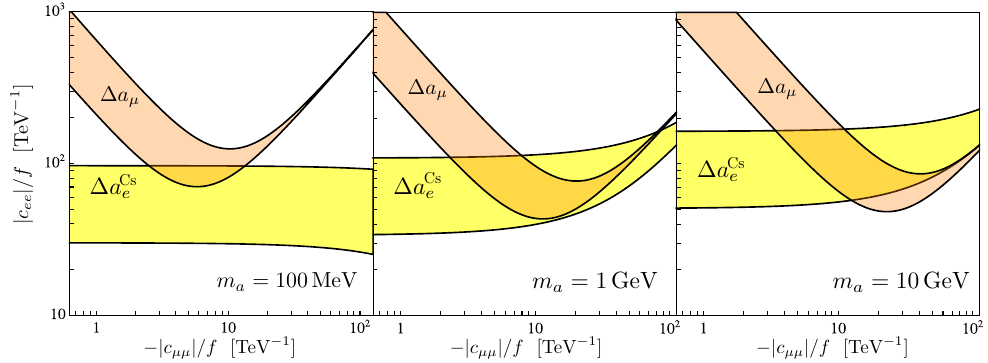
(yellow) can be explained at 95% CL e = 100 MeV, 1 GeV and 10 GeV. a is not shown as the deviation is < 2 σ e